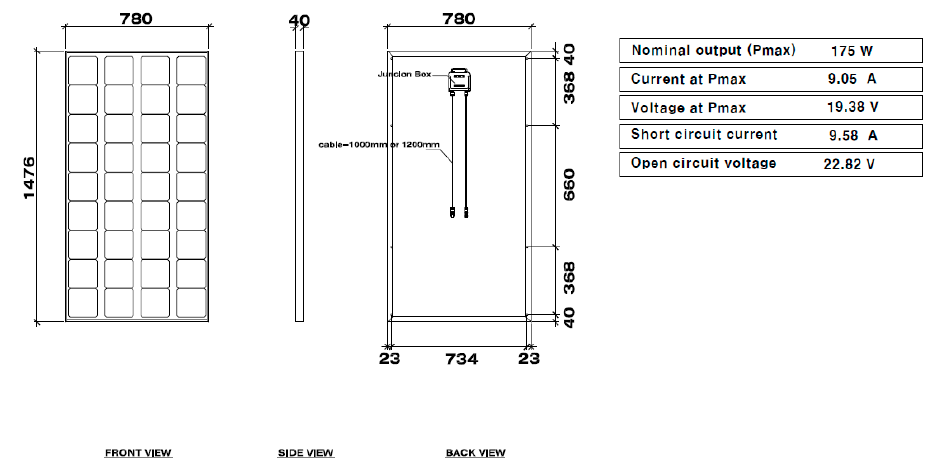
Figure 13. Bifacial-panel specification (Section D).